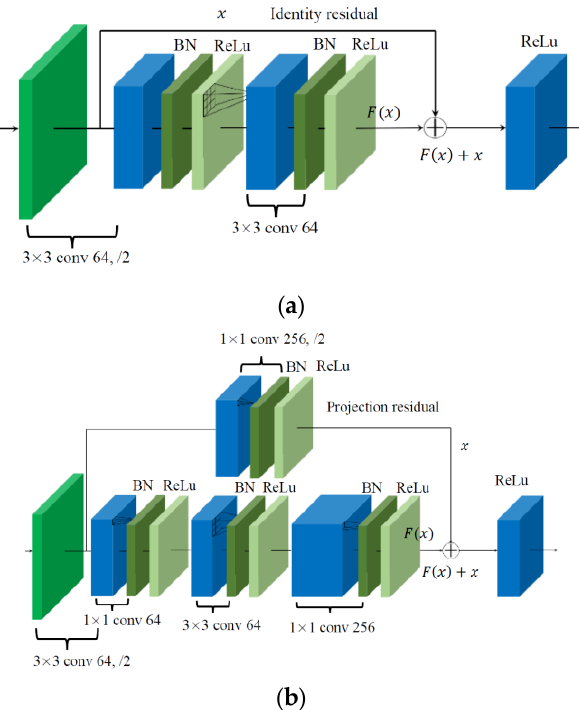
Figure 2. Residual network structure. ( a ) Identity residual. ( b ) Projection residual.